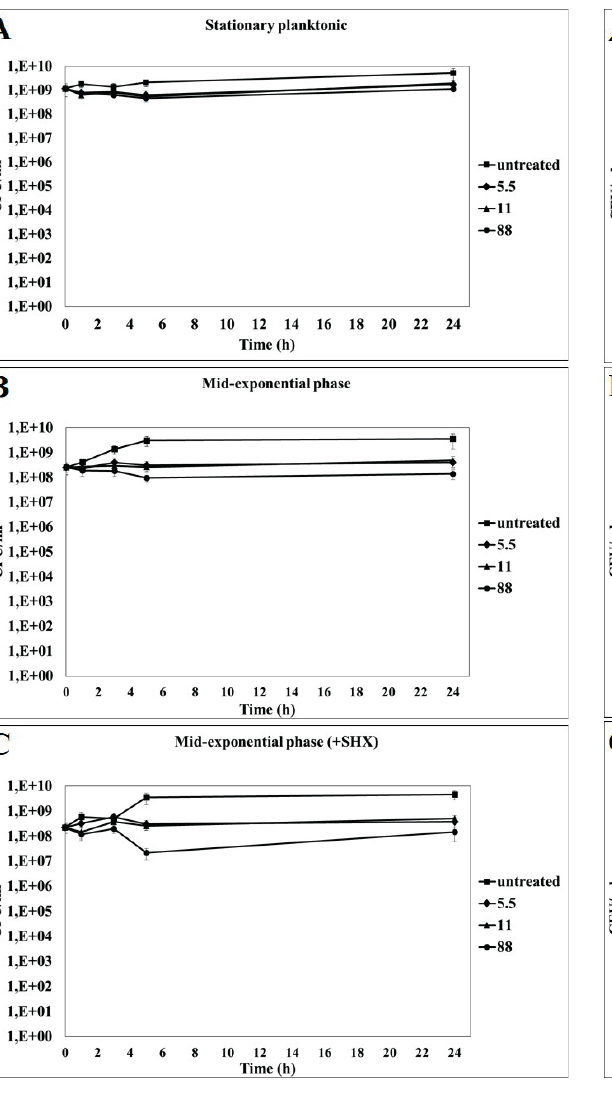
Fig. 2. Killing of P. aeruginosa PAO1 wild-type cells by ceftazi- dime.